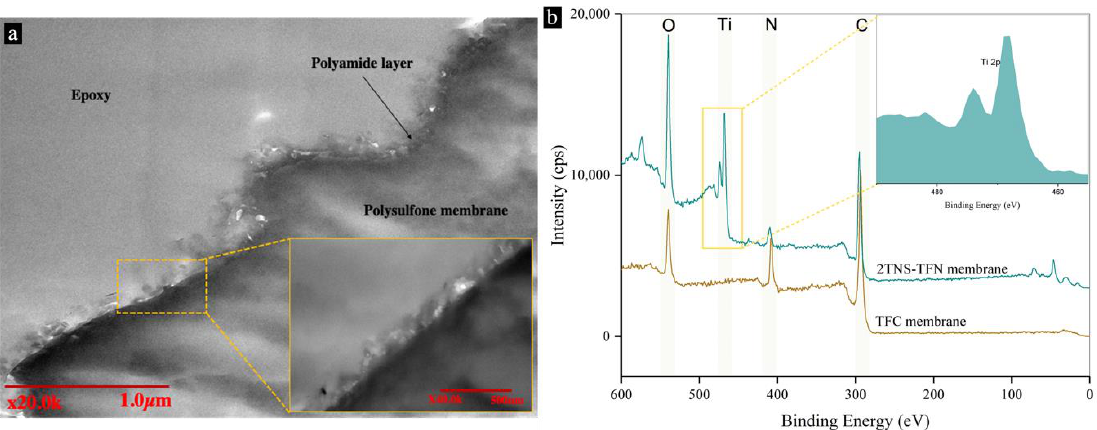
Figure 2. ( a ) TEM microscopic of 2TNS-PA TFN membrane with scale bar (inset: magnified TEM microscopic of PA layer) and ( b ) XPS full-scan spectra of TFC and 2TNS-PA TFN membranes. (Inset: the magnified peaks of TNS assembled on the surface of PA membrane.).